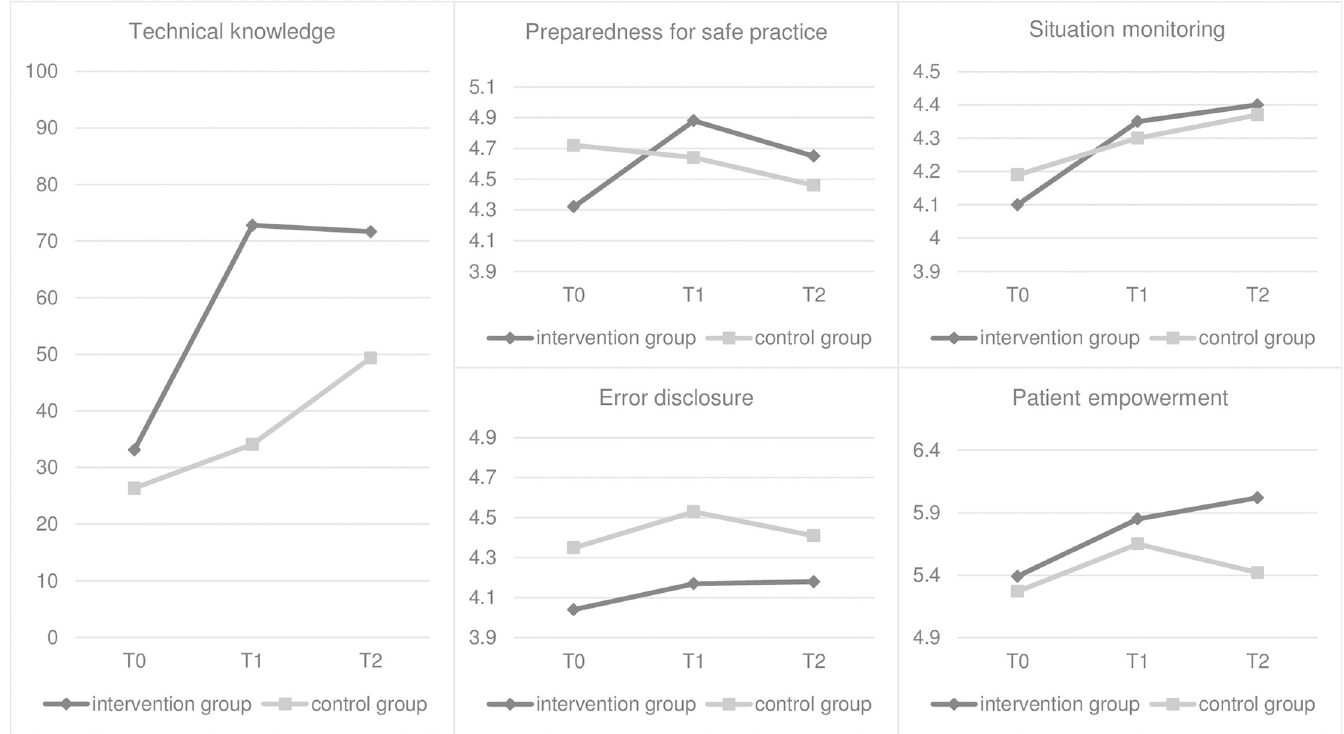
Fig 2. Results of the repeated measures design for T0, T1 and T2. Graphs show results of technical knowledge , the GAPSQ scales preparedness for safe patient practice , error disclosure and patient empowerment and the TTAQ scale situation